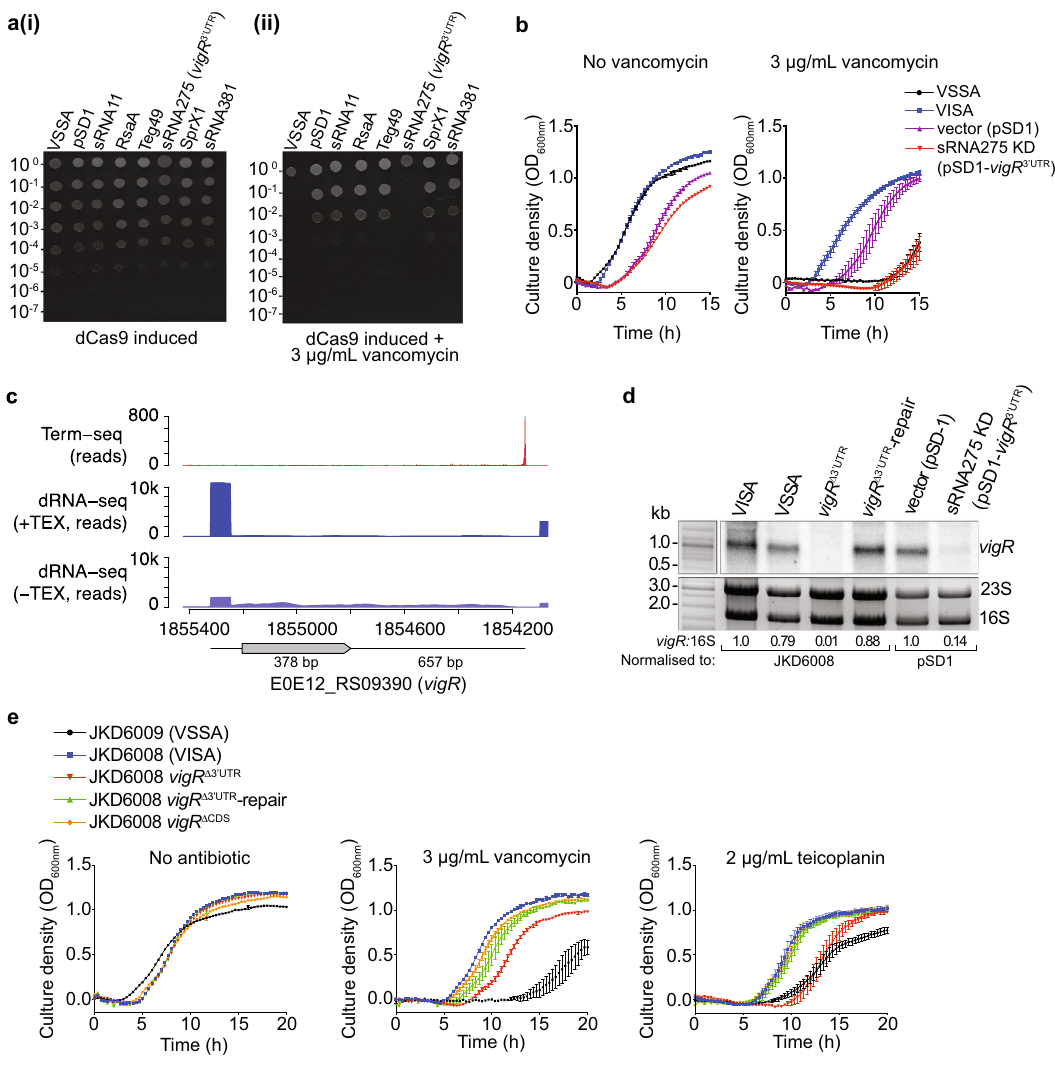
Fig. 4 The regulatory RNA, sRNA275 ( vigR 3 ′ UTR), is required for intermediate-vancomycin tolerance in S. aureus JKD6008. a Spotted dilution assays quanti fi ed vancomycin tolerance in sRNA induced CRISPRi knockdown strains. Small RNAs targeted by CRISPRi sgRNAs are indicated above. Culture dilution is indicated left. The cultures were grown in the absence (i) or presence (ii) of 3 μ g/mL vancomycin. b Growth curves of VISA (JKD6008), VSSA (JKD6009), pSD1 (vector only control, JKD6008 pSD1), and pSD1- vigR 3 ′ UTR (JKD6008 vigR 3 ′ UTR CRISPRi knockdown). Cultures were grown in MH media with or without sub-inhibitory vancomycin (3 μ g/ml). c Mapping vigR mRNA 5 ′ and 3 ′ ends. Plots indicate raw read data mapping to vigR (E0E12_RS09390) generated using Term-seq ( top ), or dRNA-seq with ( middle ) or without ( bottom ) terminator exonuclease (TEX). The position of the E0E12_RS09390 CDS is indicated below. d Northern blot analysis of vigR mRNA. Total RNA was extracted from strains indicated ( top ) and probed for vigR RNA. Excepting VSSA (JKD6009), all strains are derived from JKD6008. Sybr Green II stained 23S and 16S rRNAs are indicated below as a loading control. Quanti fi cation of the ratio of 16S rRNA to vigR by densitometry is indicated below. e Growth curves for VSSA (JKD6009), VISA (JKD6008), JKD6008 vigR Δ 3 ’ UTR , JKD6008 vigR Δ 3 ’ UTR -repair, and JKD6008 vigR Δ CDS mutants. Strains were grown in MH media supplemented with antibiotics indicated